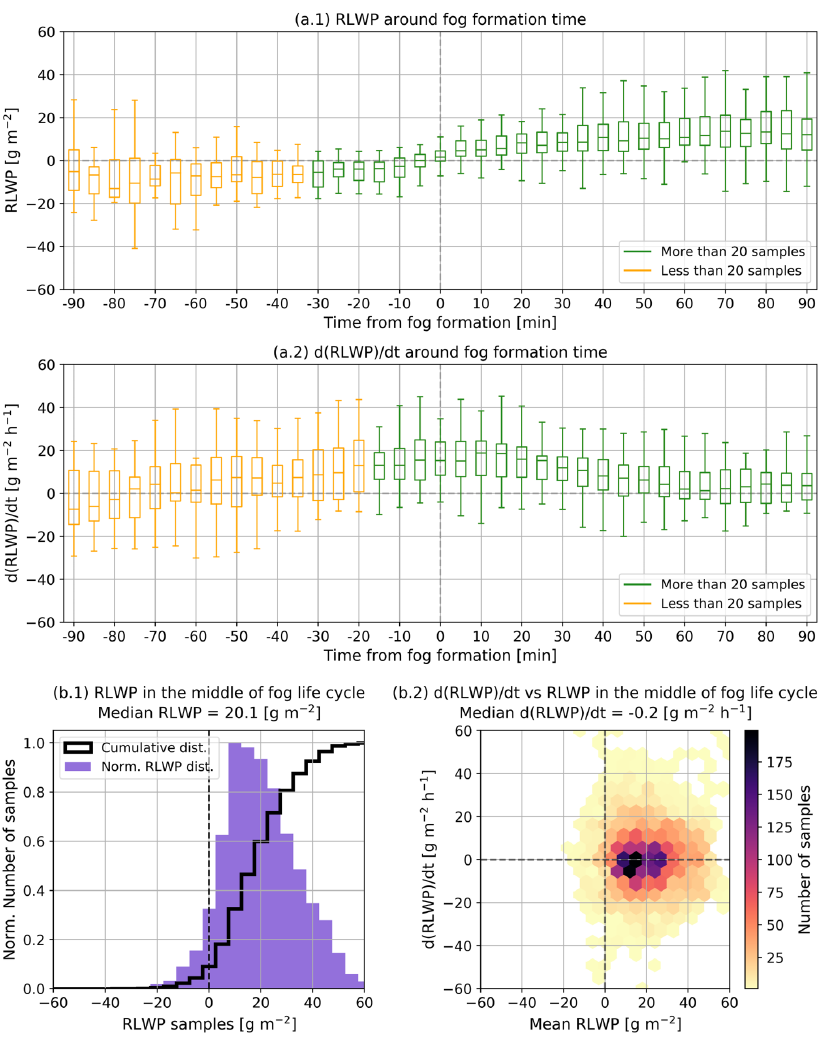
Figure 10. The boxplots of (a.1) and (a.2) represent RLWP and dRLWP / d t statistics for each time block 90min before and after fog formation. The boxplot shows the 25th, 50th, and 75th percentiles and the maximum and minimum values. The number of samples per bin is shown in Fig. S2 of the Supplement. Panels (b.1) and (b.2) show RLWP and dRLWP / d t statistics during fog middle life, between 90min after fog formation and 90min before dissipation, calculated using 4064 and 3952 samples, respectively. The ordinate axis of (b.1) is associated with the cumulative and normalized